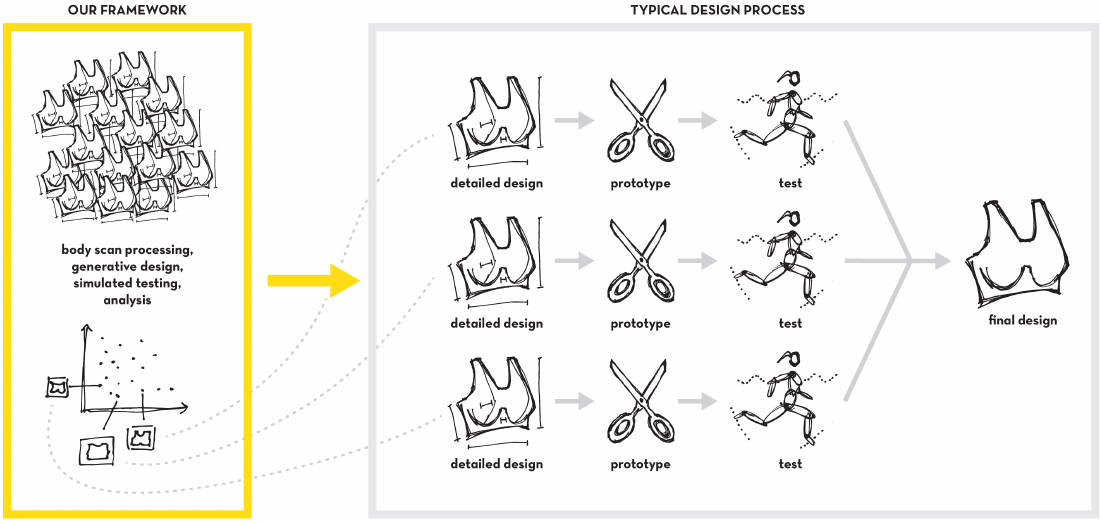
Figure 1. Sports bra design and proposed